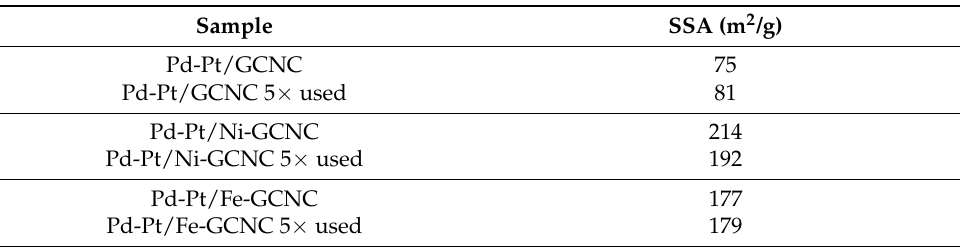
Table 1. Specific surface area of the developed granulated carbon nanocomposite supported Pd-Pt decorated catalysts before and after using them 5